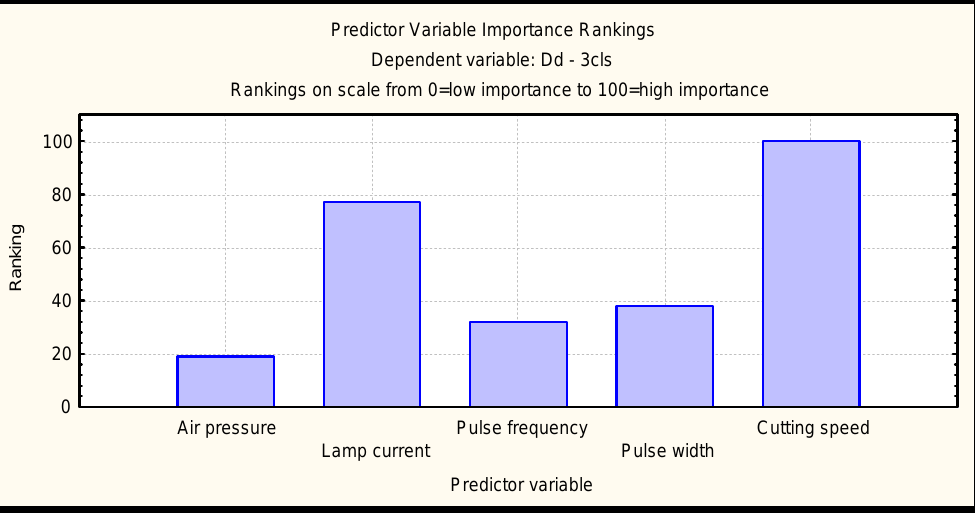
Fig. 14. Predictor variable importance ranking for deviation of